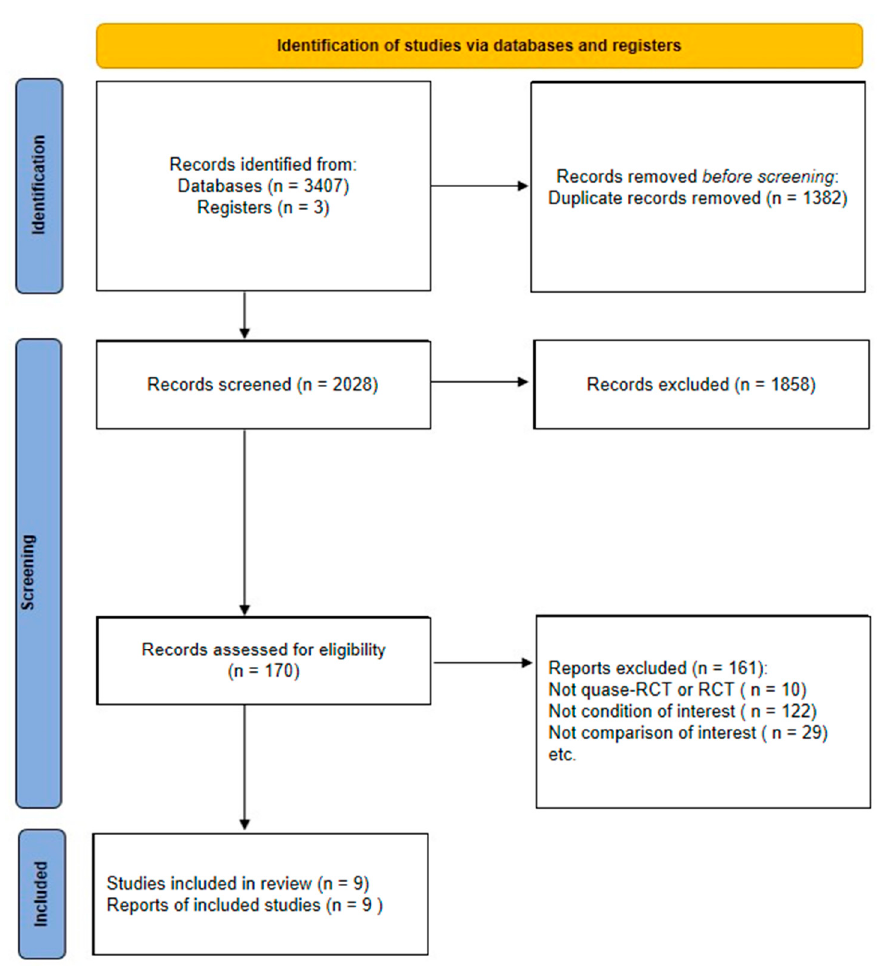
Figure 1. Flow of studies through the review. RCT: randomized clinical trial.